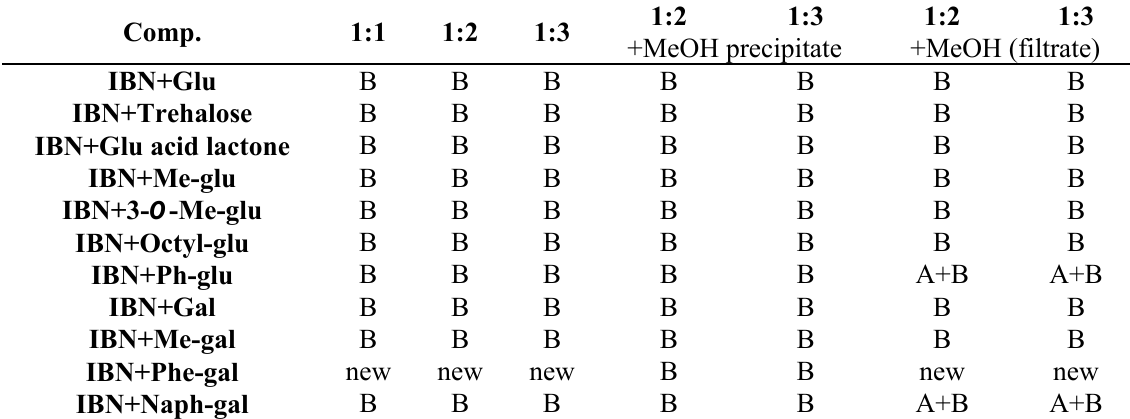
α - D -glucose: Glu, D -(+)-trehalose, D -(+)-gluconic acid δ -lactone: Glu acid lactone, methyl- α - D -